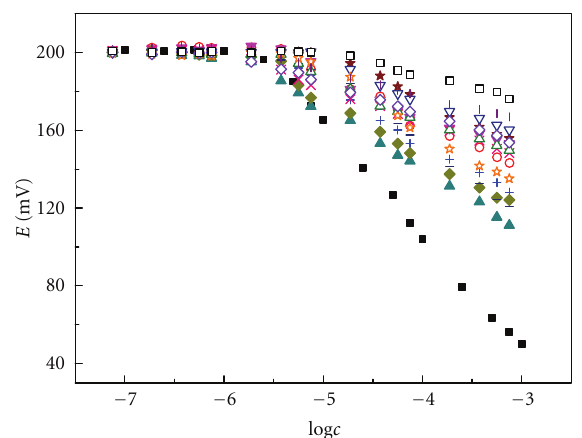
) Br (cid:2) ; ( ) (cid:6) (cid:8)